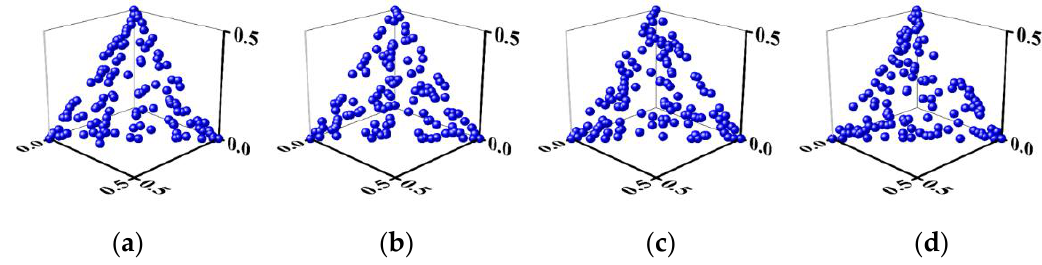
Figure 3. Pareto front of 3-objective DTLZ1 for problems ( a ) NSGA-II/CSDR 1 ( b ) NSGA-II/CSDR 2 ( c ) NSGA-II/CSDR 3 ( d ) NSGA-II/CSDR 4 .